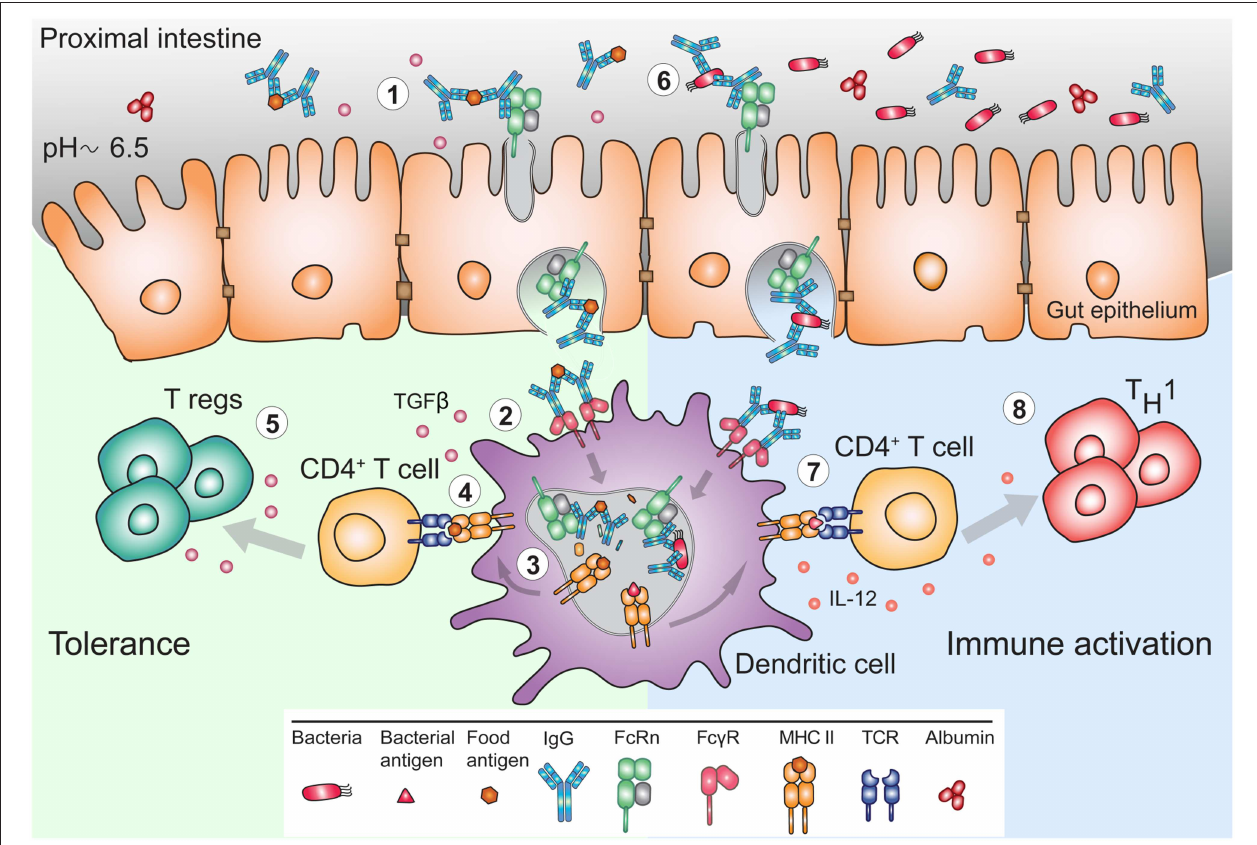
FIGURE 3 | FcRn mediates bidirectional transport and immune response to IgG and IgG immune complexes in the gut. (1) The pH of the mucosal surface of the proximal intestine can be slightly acidic, such that FcRn can bind maternal IgG and IgG IC already at the cell surface, and transcytose these to the basolateral side. (2) APC such as DC, can bind and actively internalize IgG IC via Fc γ R. (3) FcRn in APC assists in antigen processing and delivery of the IgG IC to antigen loading compartments where peptides derived from these complexes can be loaded onto MHC II for presentation to CD4 + T cells. (4) In early life, presentation of antigen-derived peptide on MHC II in presence of other maternal milk-derived factors provides (5) tolerogenic environment to CD4 + T cells. In these instances, FcRn expression by APC is crucial for induction of CD4 + Foxp3 + regulatory T cells (Treg). (6) In adulthood, during infection, pathogen derived antigens bound by lumenal IgG will be transported across mucosal membrane in an FcRn-dependent manner and (7) delivered to APC, which process and present antigens, (8) for subsequent activation of immune